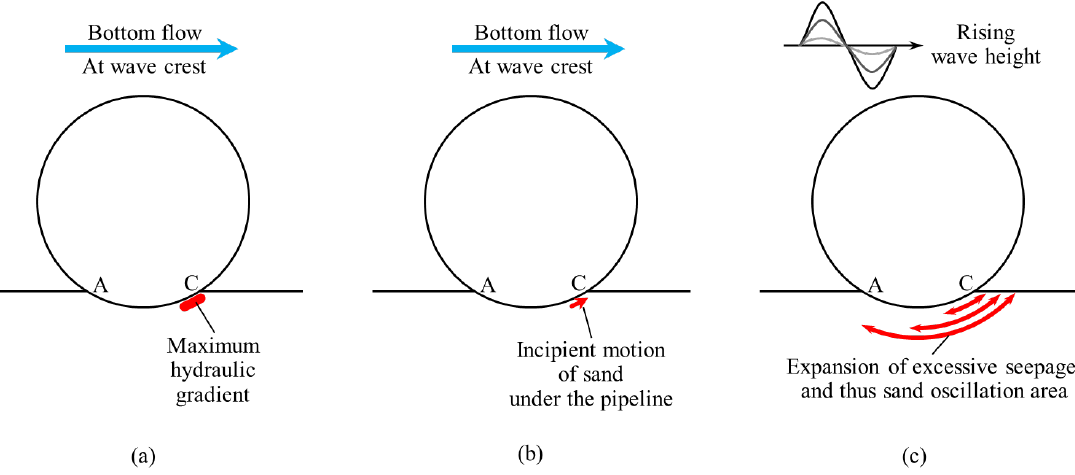
Figure 6. Illustration of the sediment incipient motion under the pipeline ( a ) maximum hydraulic gradient under the pipeline; ( b ) sediment incipient motion near the downstream mudline; ( c ) increasing oscillating amplitude and extending coverage of the sediment oscillation.